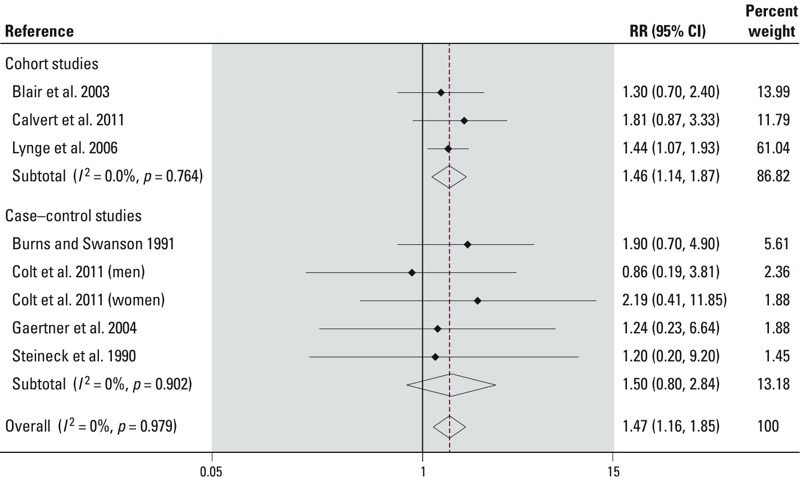
Forest plot of cohort and case–control studies included in the meta-analysis that assessed the risk of bladder cancer in relation to occupation as a dry cleaner. See Table 1 for details on included studies.